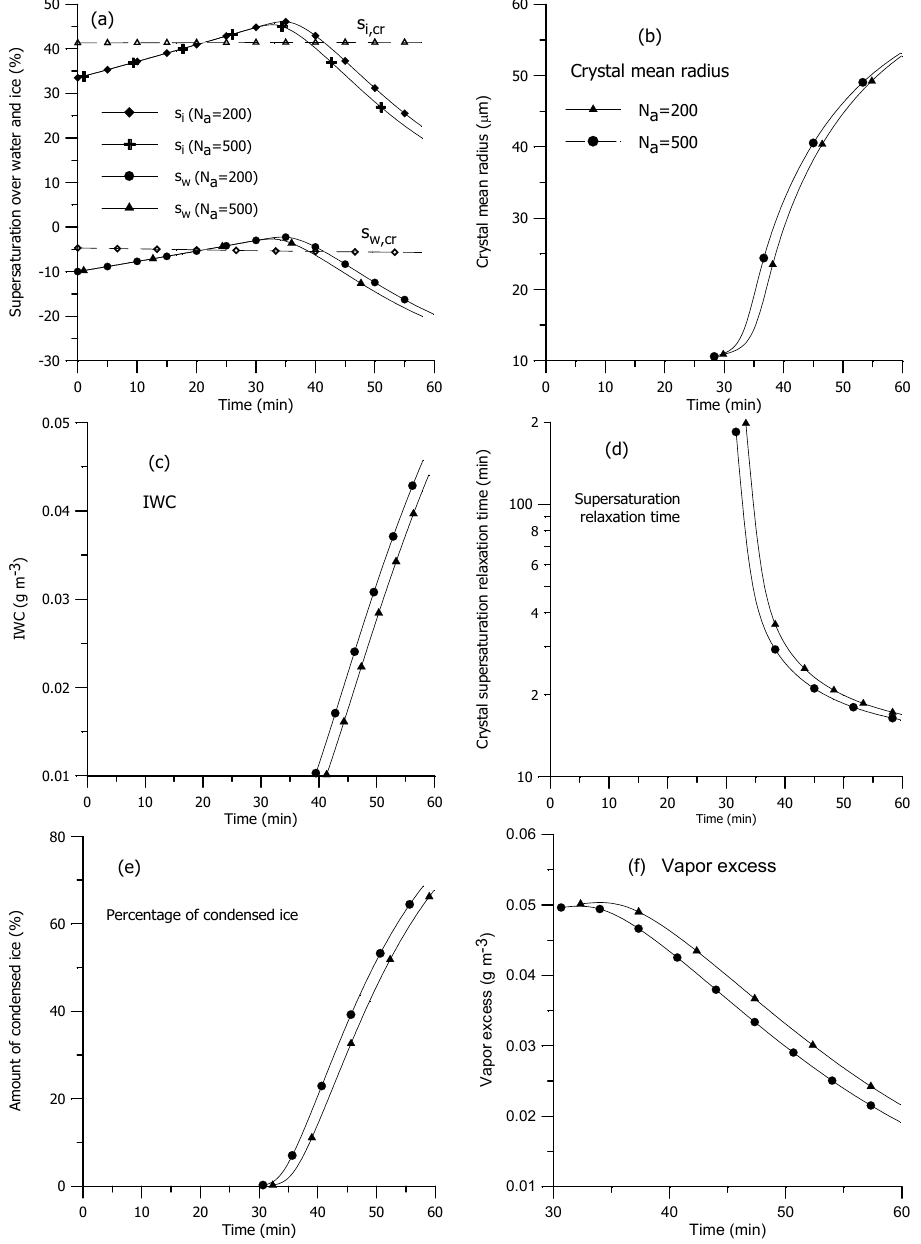
Fig. 4. Comparison (continuation) of homogeneous ice nucleation kinetics at N a = 200cm − 3 (solid circles) and 500cm − 3 (triangles), at − 40 ◦ C and the other parameters as in Fig. 3. (a) Supersaturations over water, s w , and ice, s i , and critical supersaturations, s w , cr , and ice, s i , cr , %; (b) crystal mean radius, µm; (c) ice water content, gm − 3 ; (d) crystal supersaturation relaxation time, min; (e) relative amount of condensed ice, %; (f) vapor excess, g m − 3